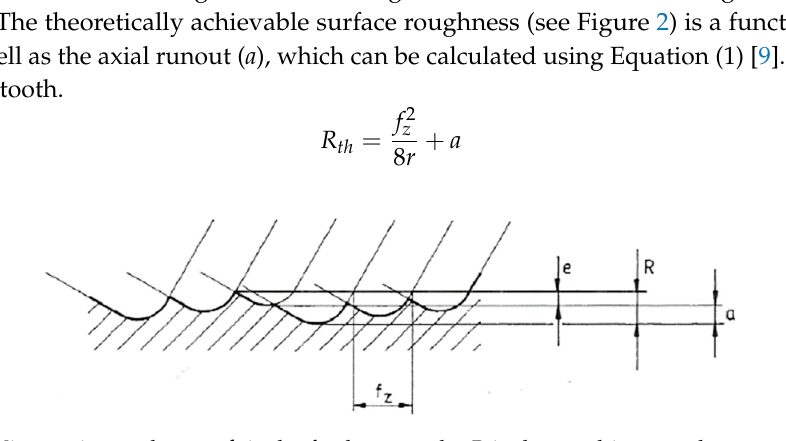
Figure 2. Kinematic roughness. f z is the feed per tooth. R is the resulting roughness, whereas the resulting deviation from the ideal line is specified by e and a [9].